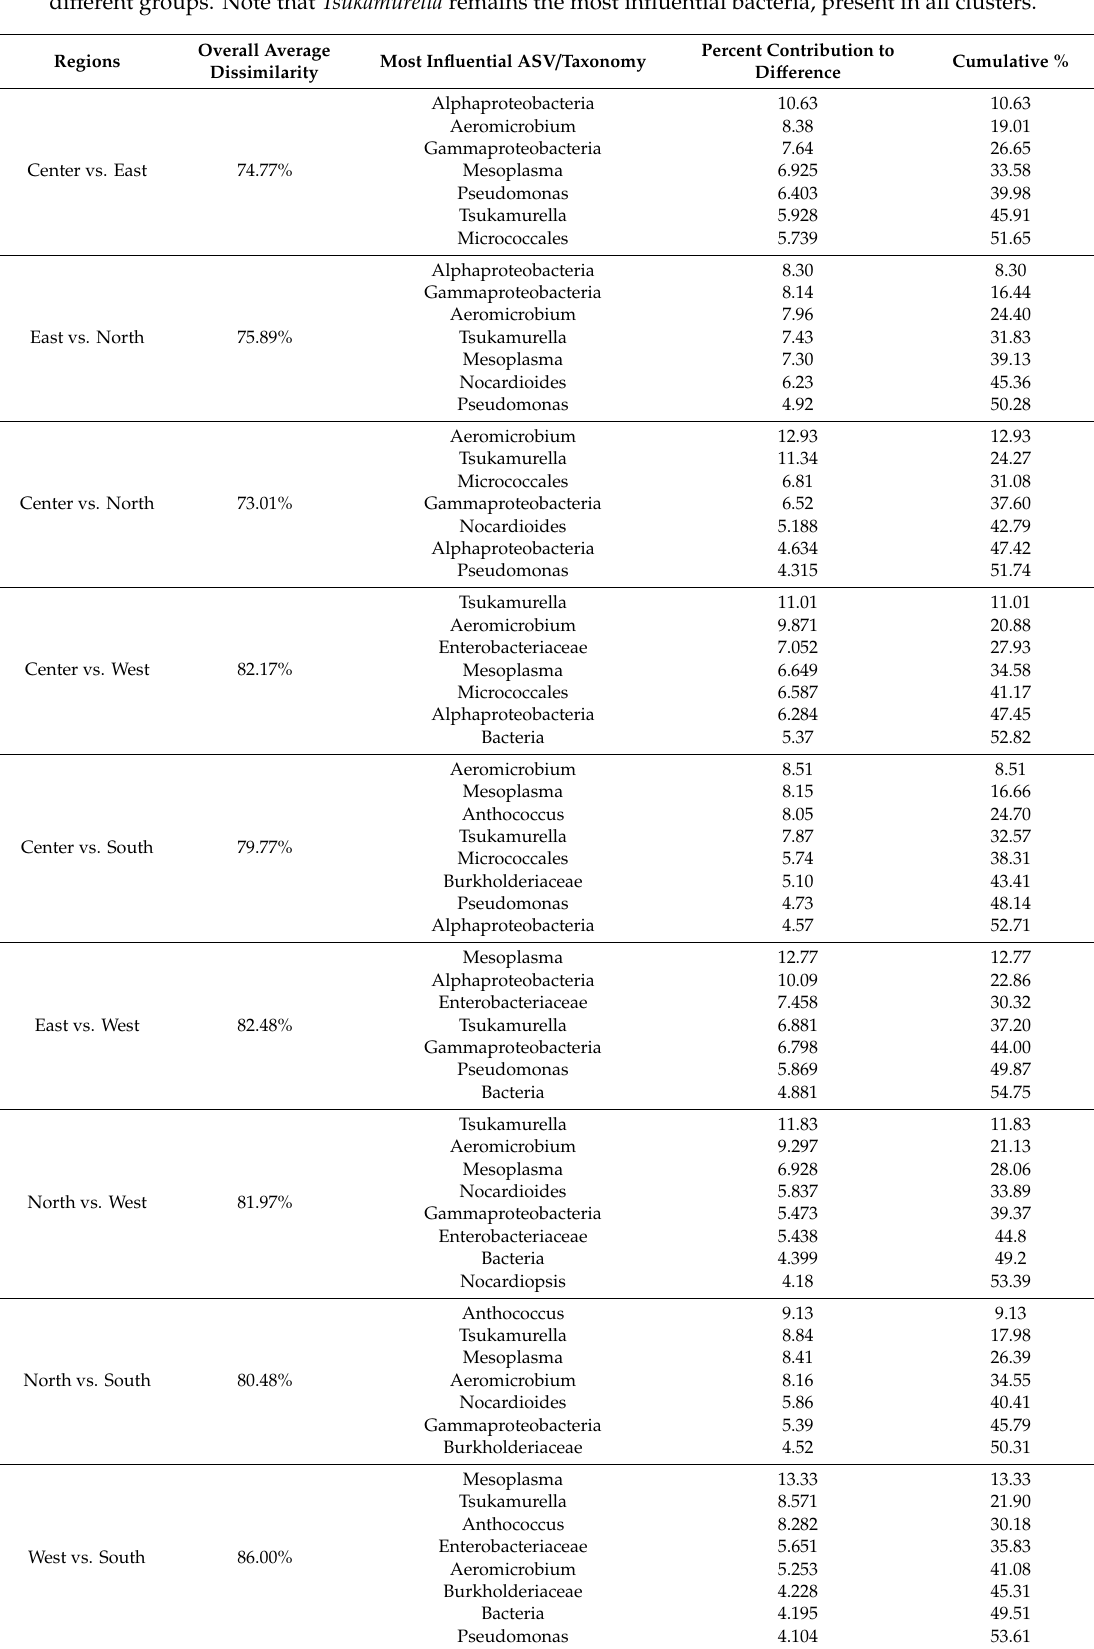
Table 3. SIMPER analysis of main bacteria contributing to di ff erences between each region pair. This test indicates the contribution of specific ASVs to the observed di ff erences in community structure among di ff erent groups. Note that Tsukamurella remains the most influential bacteria, present in all